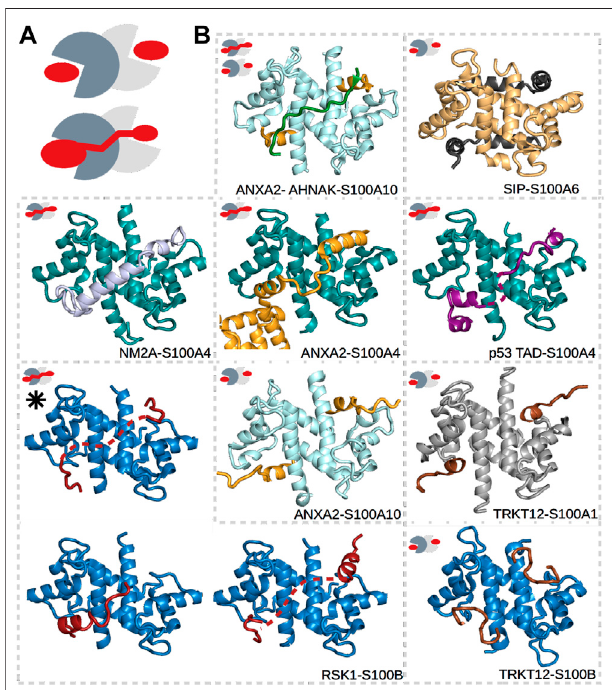
FIGURE 2 | Different types of interactions in S100 complexes. (A) Schematic representations of symmetric (top) and asymmetric (bottom) interactions made by S100 proteins. The monomers of S100 proteins are representedinlightanddarkgray,whilethepartnerisinred. (B) S100A1 (gray), S100A4 (deep teal), S100A6 (pale yellow), S100A10 (pale cyan), and S100B (sky blue) in complex with TRKT12 (brown, PDB: 1MQ1 and 2KBM) (McClintock and Shaw, 2003), RSK1 (red, PDB: 5CSN, 5CSJ, and 5CSI) (Gógl et al., 2016), NM2A (light blue, PDB: 3ZWH) (Kiss et al., 2012), ANXA2 (bright orange, PDB: 5LPU and 4HRE) (Oh et al., 2013; Ecsédi et al., 2017), SIP (black, PDB: 2JTT) (Lee et al., 2008), AHNAK (forest green, PDB: 4FTG) (Ozorowski et al., 2013), and p53 (deep purple, PDB: 6T58) (Ecsédi et al., 2020).Smallpictograms show the nature ofeach interaction, i.e., whether itis symmetric or asymmetric. The black asterisk marks the structure of the RSK1 – S100B complex determined in part using SAXS data. Dashed lines represent the expected locations of fl exible regions, which were not visible during model